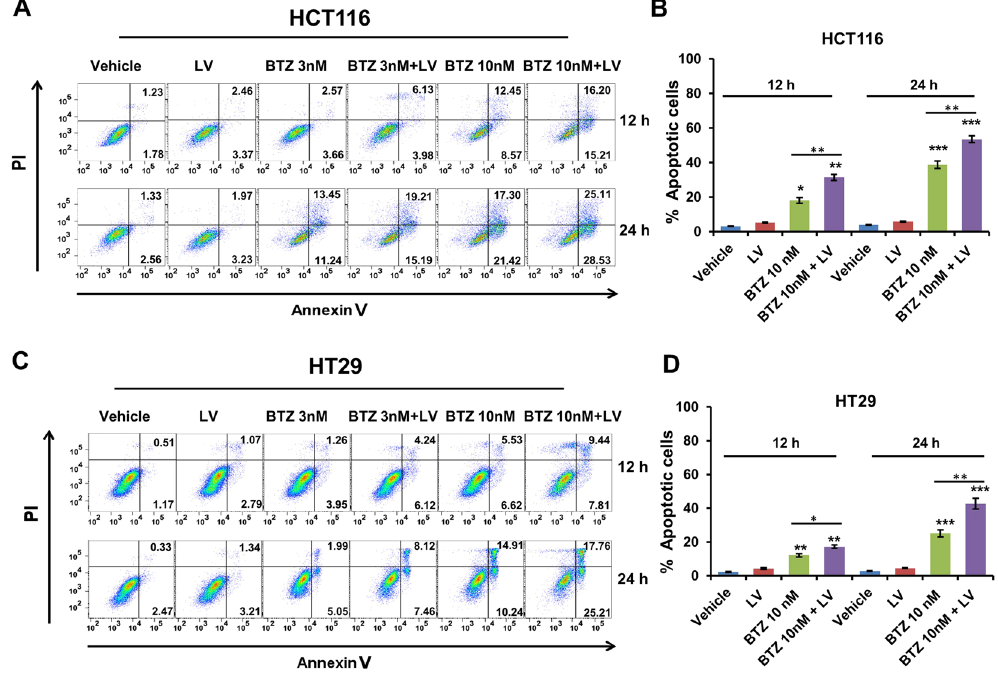
Figure 2. Bortezomib and leucovorin increase apoptosis of CRC cells. ( A,C ) HCT116 and HT29 cells were treated with the combination of bortezomib (3 or 10 nM) and leucovorin (10 µ M) or either drug alone for 12 h and 24 h, respectively. The treated cells were stained with FITC-annexin V/propidium iodide, and apoptosis was analyzed with flow cytometry. Experiments were performed three times with one representative experiment shown. Cells that underwent late apoptotic death and early apoptotic death are in the upper and lower right quadrants, respectively. ( B,D) . Percent apoptotic cells. One-way ANOVA was performed to compare each treatment group with the vehicle control (PBS) or to compare the combination with bortezomib